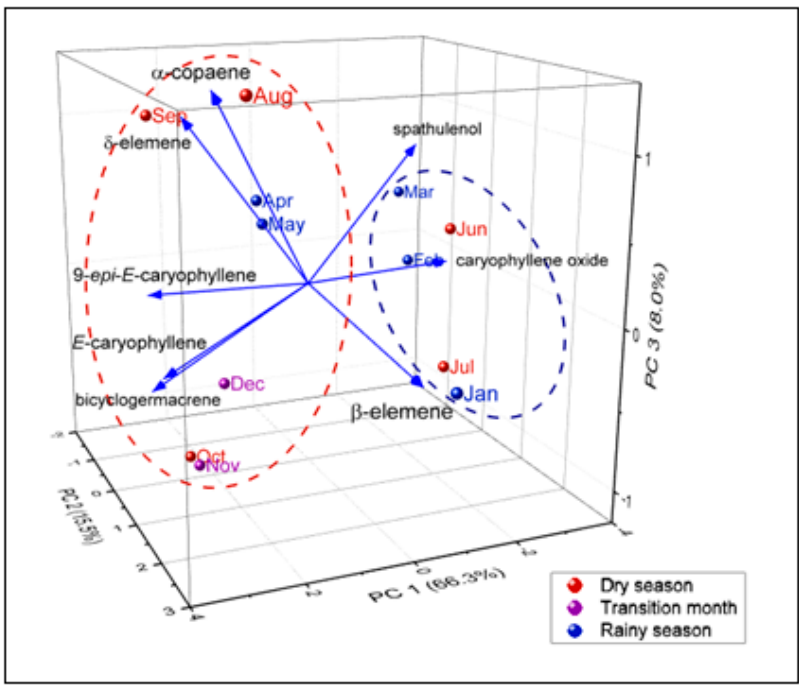
Figure 6. Principal component analysis (PCA) based on the primary constituents (above 5%) of E. patrisii essential oils.